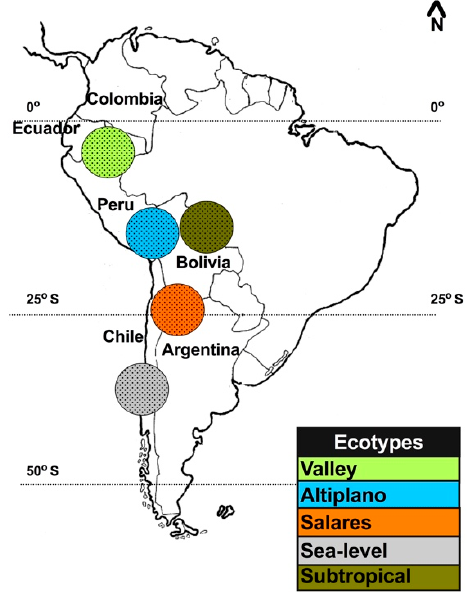
Figure 1. Geographic distribution of the five quinoa ecotypes.